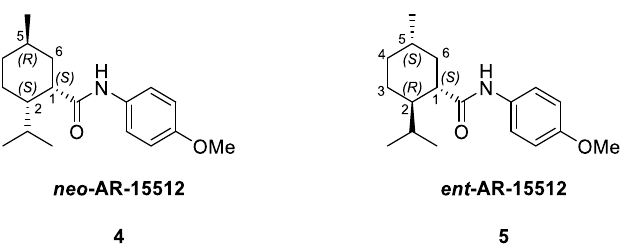
Figure 1. Structure and configuration of the target compounds in this